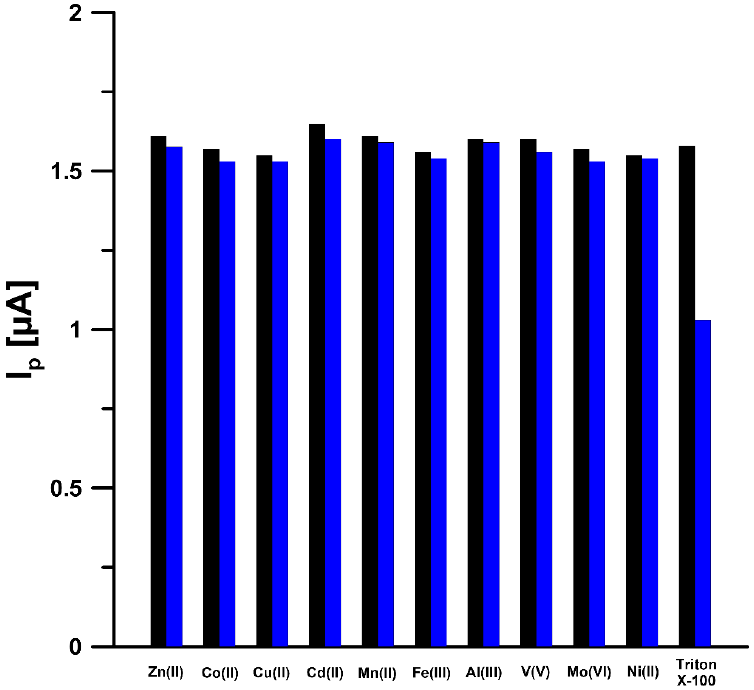
Figure 10. Histogram bars of the U(VI) peak current in the presence of interferents.